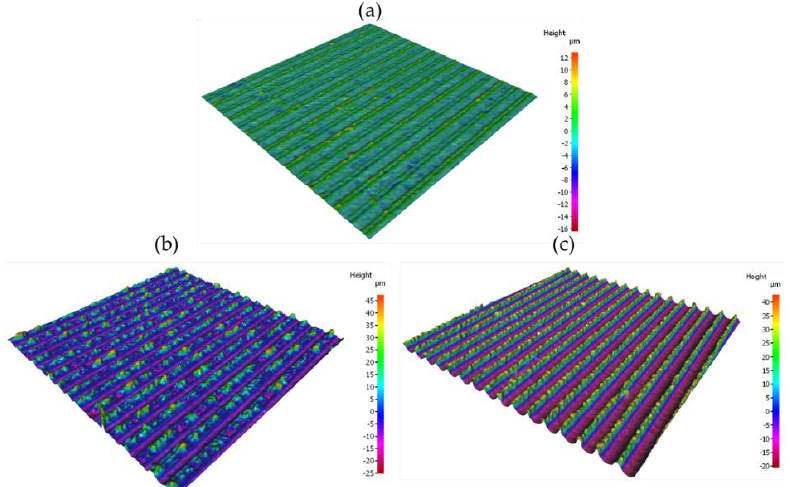
Figure 4. Surface topography for samples textured: ( a ) Ed = 11.79 J/cm 2 and Vs = 10 mm/s; ( b ) Ed = 35.37 J/cm 2 and Vs = 10 mm/s; ( c ) Ed = 35.37 J/cm 2 and Vs = 100 mm/s.